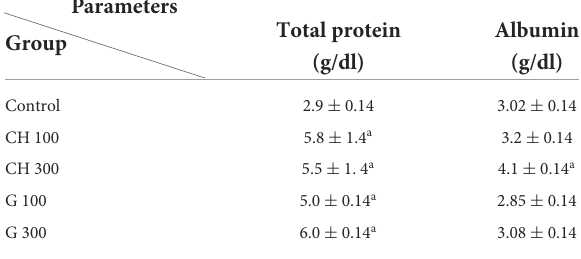
TABLE 4 Effect of chemical and green TiO 2 NPs on protein profile of control and experimental groups (mean ±